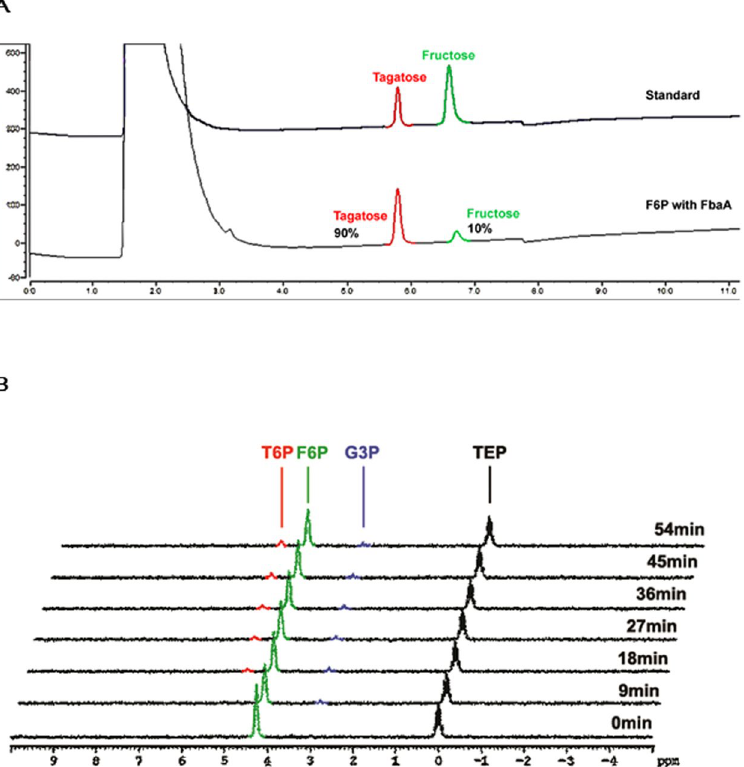
Figure 2. Bio-LC diagram and 31 P-NMR spectra for the reaction of F6P with FbaA. ( A ) Bio-LC diagrma of T6P biocoversion from F6P by FbaA. Reactions were carried out at 50 o C for 3 h in 50 mM Tris-HCl buffer containing 0.5 mM F6P with FbaA. ( B ) 31 P-NMR spectra for the reaction of F6P with FbaA. TEP was ued as the internal